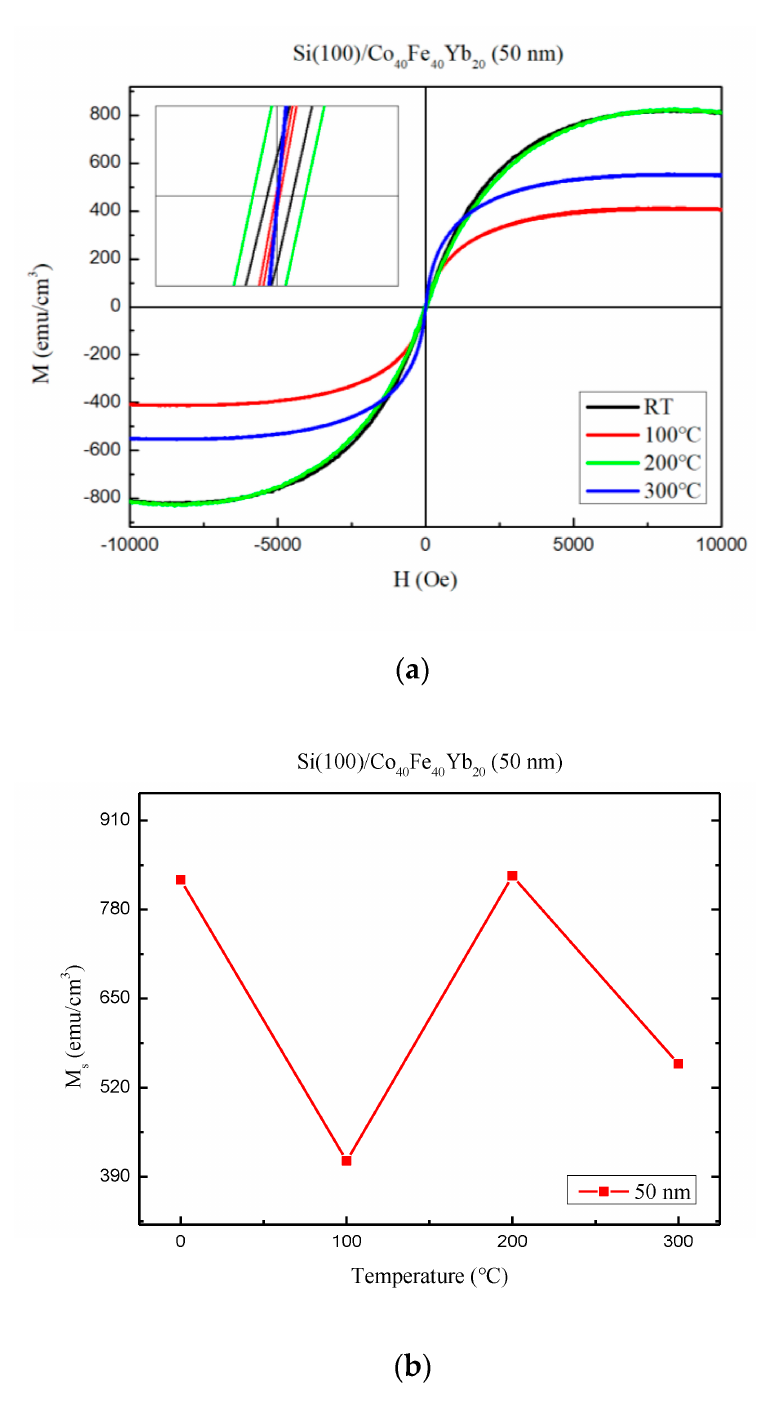
Figure 10. ( a ) In-plane magnetic hysteresis loops of Co 40 Fe 40 Yb 20 film at 50 nm. ( b ) Saturation magnetization (M S ) of Co 40 Fe 40 Yb 20 film at 50 nm.